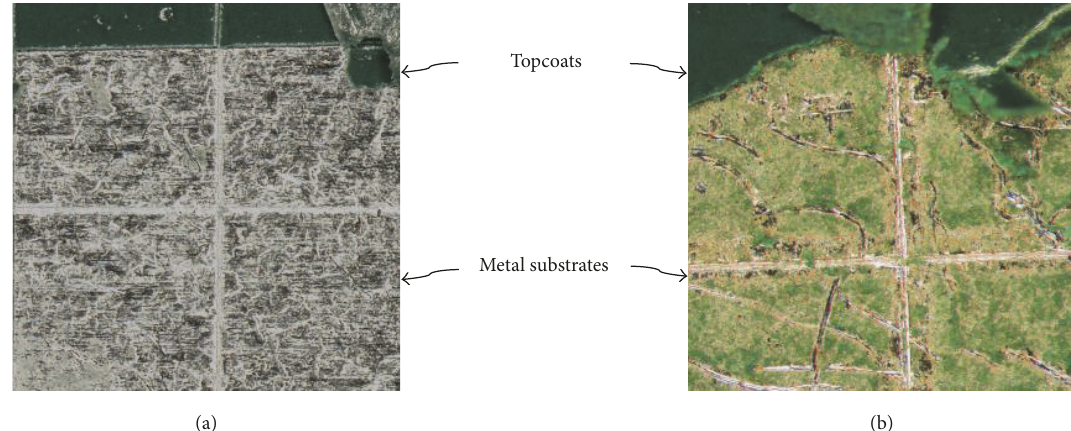
Figure 7: Micrographic test. Comparative adhesion of the PCSs when using (a) a polyurethane resin based paint with the CNPS and (b) the same paint with the PNPS. The cross-cut mesh is 0.7 × 0.7